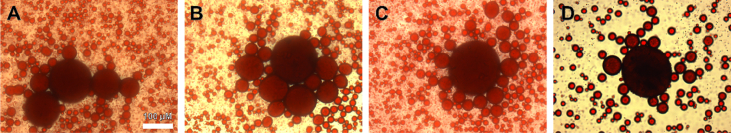
The effect of the Ni salt addition to freshly prepared Fe-based clusters. A, C – freshly formed MCs, B – after addition of 5 mM NiCl2 solution, D – after addition of 100 mM NiCl2 solution. Scale bar is 100 μm.